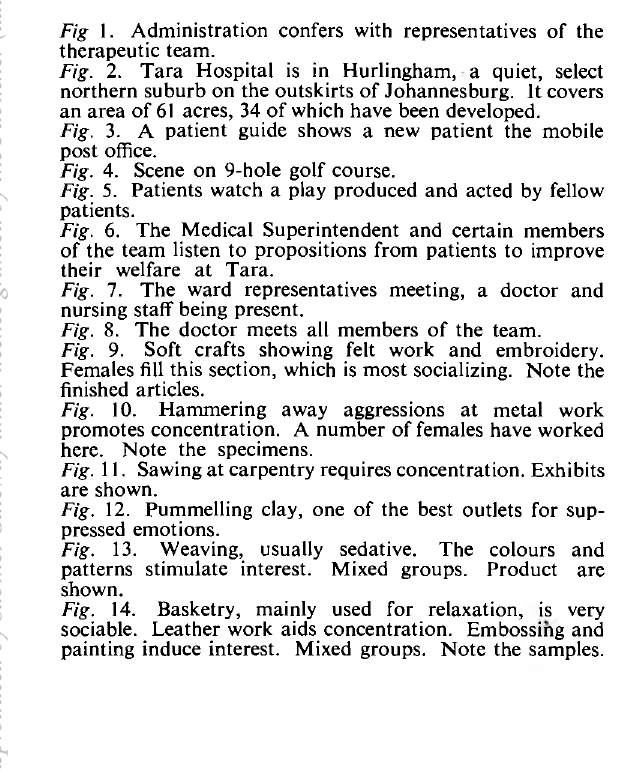
Fig 1. Administration confers with representatives of the therapeutic team. Fig. 2. Tara Hospital is in Hurlingham, a quiet, select northern suburb on the outskirts of Johannesburg. It covers